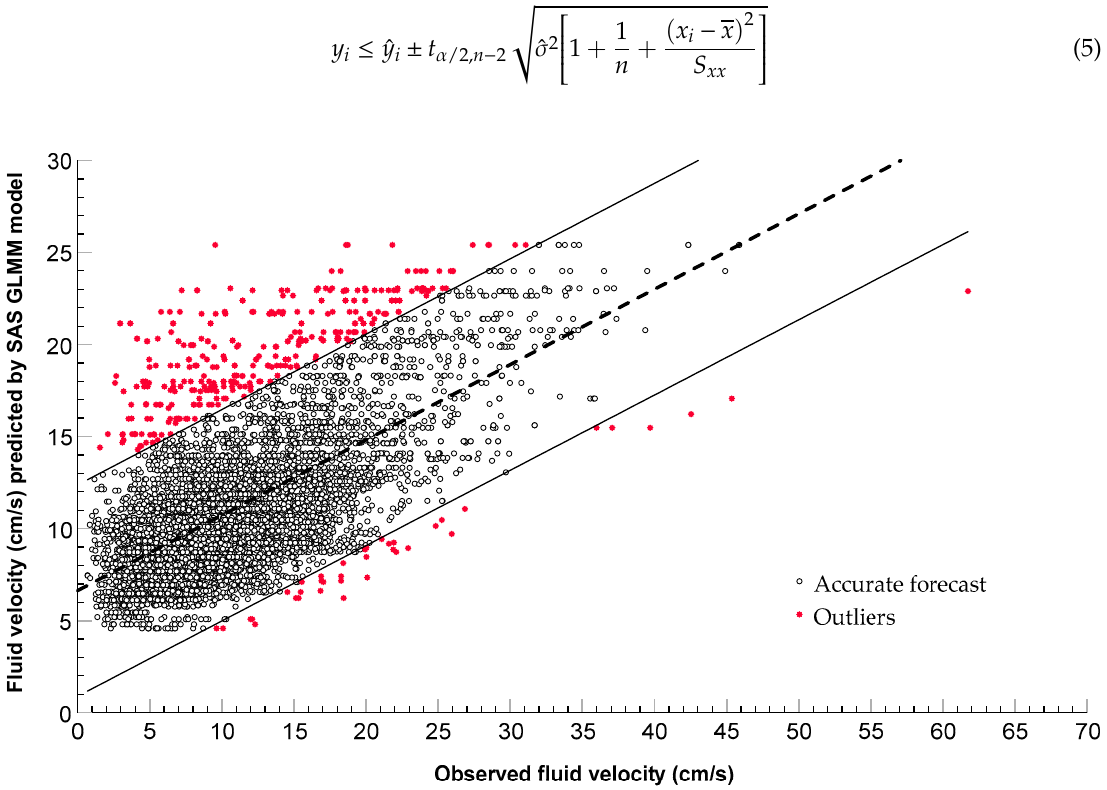
Figure 5. Linear regression between the fluid velocity (cm / s) predicted by the SAS model and that observed during the trial (regressor), with a 95% prediction limits.